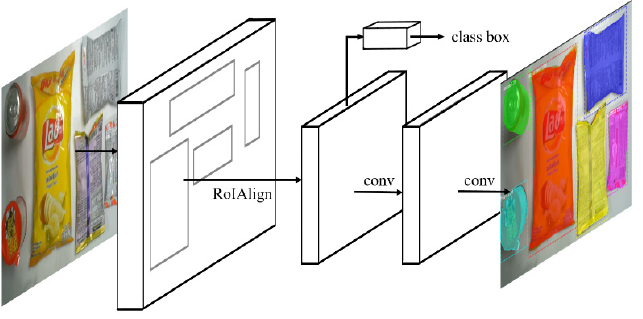
Figure 6. Framework for the mask R ‐ CNN [6].